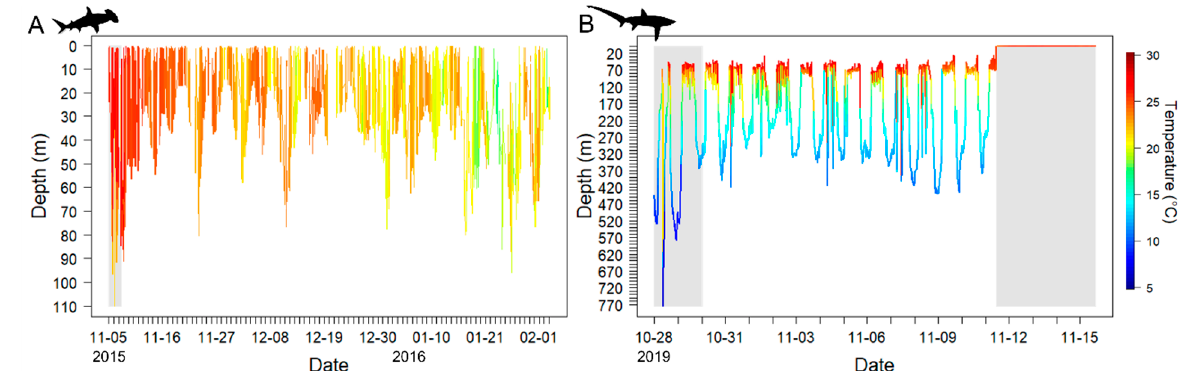
Figure 2. Vertical habitat use profiles for ( A ) a scalloped hammerhead shark and ( B ) a bigeye thresher shark, satellite tagged in the northern Gulf of Mexico. Scalloped hammerhead shark depth and temperature data were archived every 5 min and transmitted from a MiniPat (Wildlife Computers, Inc.) after a 90 d deployment. Bigeye thresher shark depth and temperature data were archived every 2 min and transmitted from a high ‐ rate PSAT X ‐ tag (Microwave Telemetry, Inc.) after a 15 d deployment. Gray areas at the beginning of each figure denote the first 48 h of post ‐ tagging abnormal behavior removed from analysis. Gray area at the end of the track of the bigeye thresher shark denotes when the X ‐ tag prematurely popped off on 11 November 2019 and was removed from analysis.